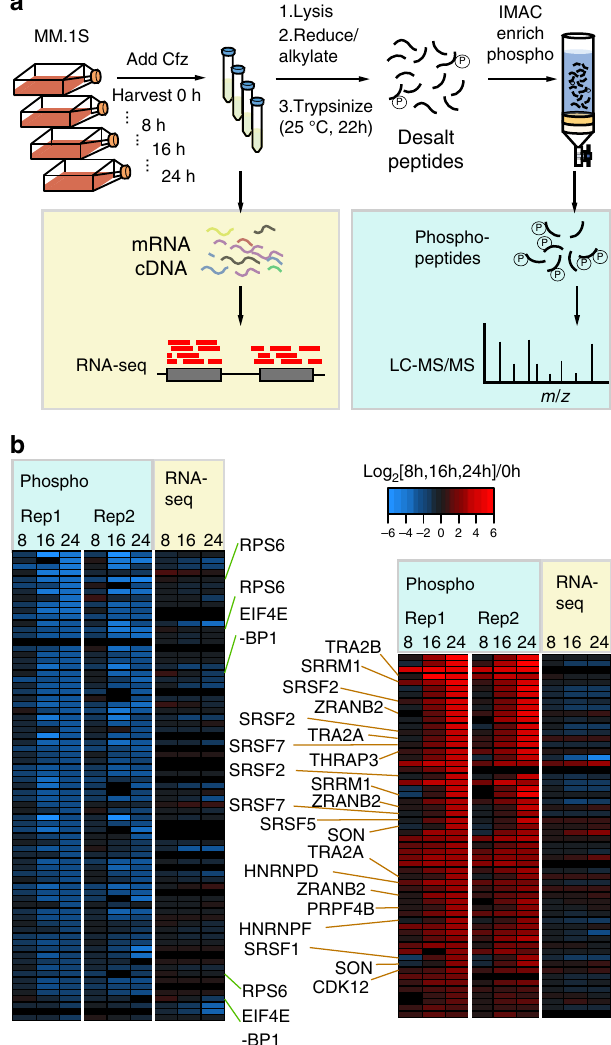
Fig. 1 Unbiased phosphoproteomic timecourse analysis of MM.1S cells treated with the PI car fi lzomib (Cfz). a Work fl ow of timecourse treatment of MM.1S cells with Cfz. Cells were allotted for both RNA-seq analysis and LC-MS/MS. b Downregulated (left panel) and upregulated (right panel) log 2 -transformed phosphopeptide MS1 intensities for two technical replicates of proteins with unchanged transcript levels (RNA-seq). Labels highlight dephosphorylation of RPS6 and EIF4EBP1 on the left and phosphorylation of splicing-related proteins on the